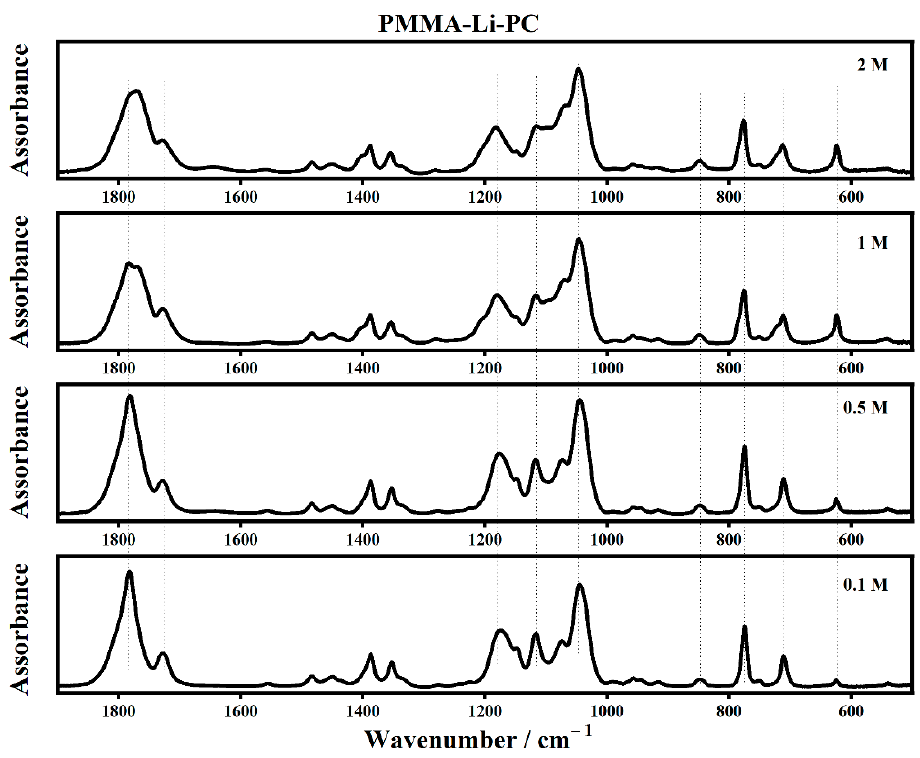
Figure 3. The IR spectra of PMMA-Li-PC for different salt concentrations in the frequency range between 500 cm − 1 and 1900 cm − 1 .